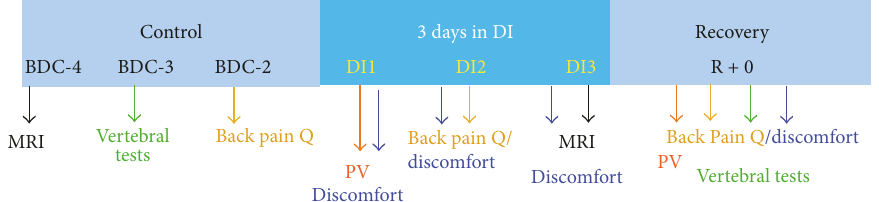
Figure 2: Tests resumed in chronology during all the experience. Tests used before dry immersion (control period: BDC for Base Data Collection), during the 3 days in DI (DI1, DI2, and DI3), and at recovery (MRI: Magnetic Resonance Imaging; back pain Q for Questionnaire, PV for Plasma